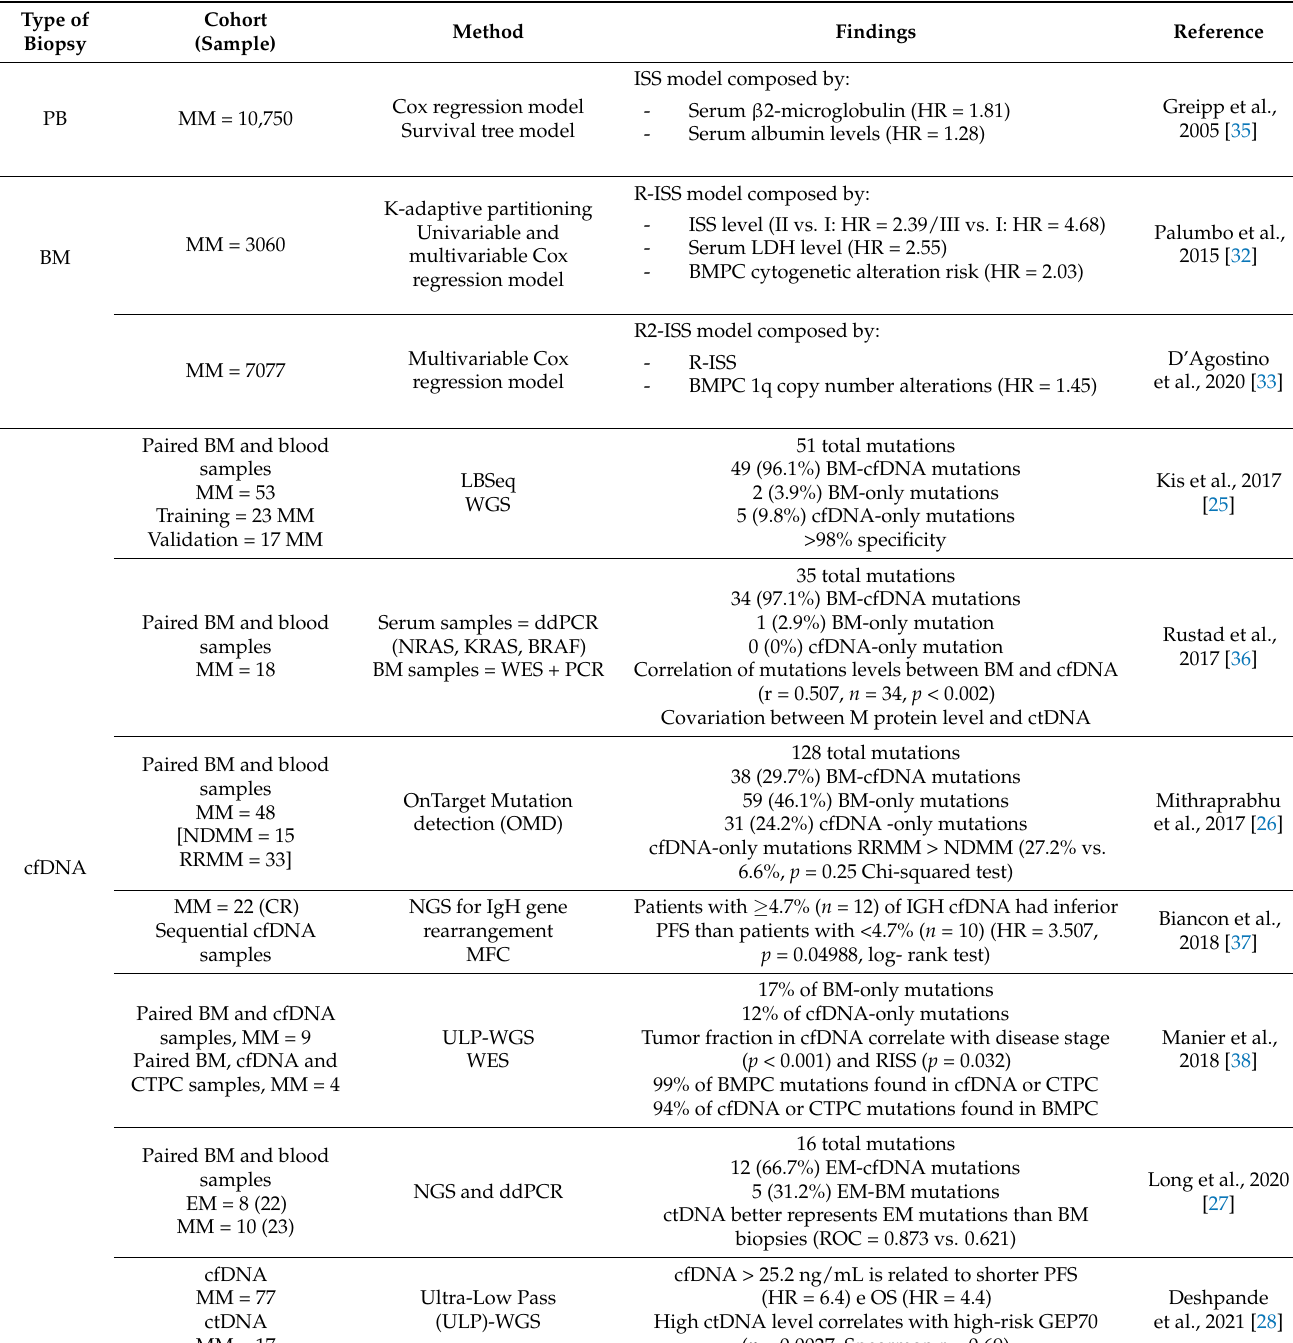
Table 2. Summary of BM and liquid biopsies evidence as prognosis